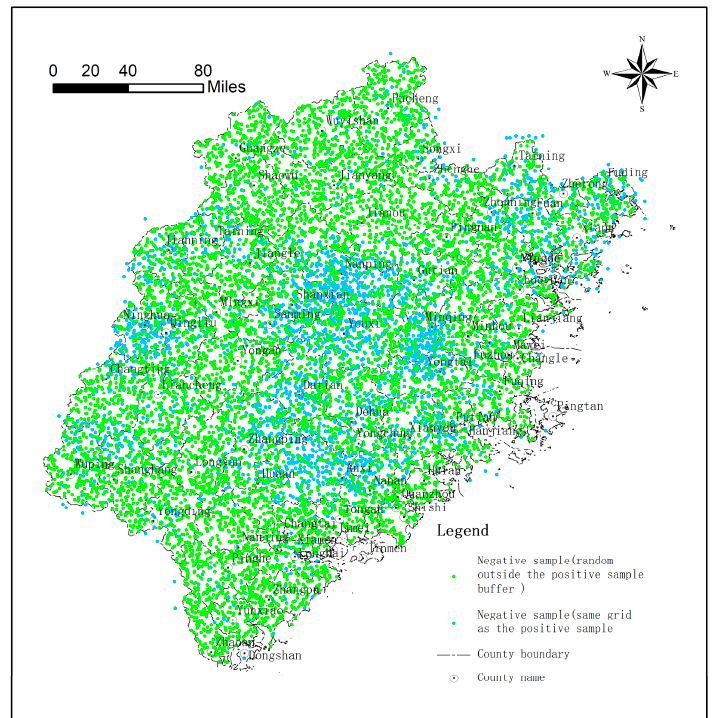
Figure 7. Spatial distribution map of negative samples.